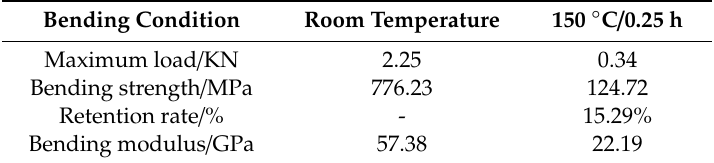
Table 4. Bending stress of braided structure specimens at room temperature and 150 ◦ C.